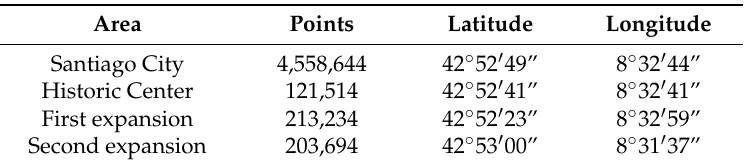
Figure 7. Case study data. Three well-differentiated urban areas from Santiago de Compostela (highlighted in red, green and blue) are chosen for the validation of the proposed methodology. Table 1. Case study data.